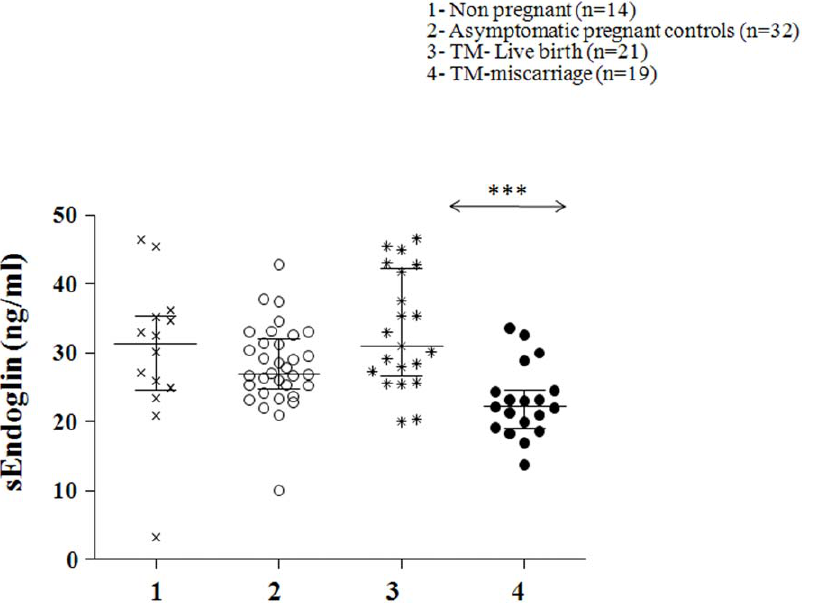
Figure 3. Scatter plot of circulating levels of serum soluble Endoglin (sEndog) in the different groups of women with median and interquartile range. Group 1 (non-pregnant women, n=14), group 2 (normal pregnant women, women, n=32), group 3 (threatened miscarriage patients with a live birth outcome, n=21) and group 4 (threatened miscarriage patients with a subsequent miscarriage, n=19). General linear analysis of variance was carried out to study the statistical significance between the groups with posthoc tests. P ,